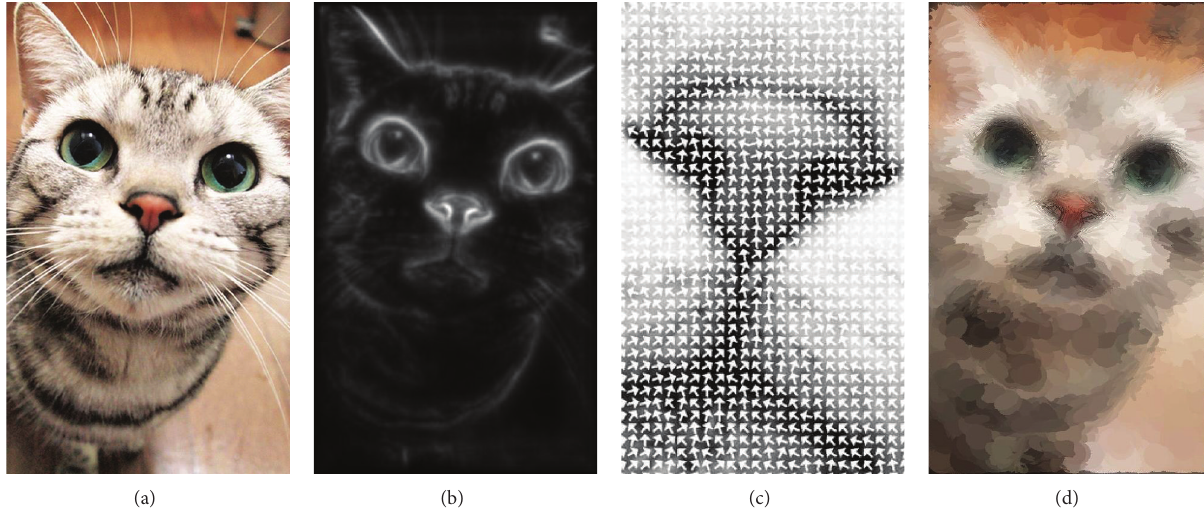
Figure 1: (a) Source image: cat; (b) saliency map; (c) direction map details of the cat’s nose; (d) Pointillism of the source image with the proposed method, 𝑁 = 19000